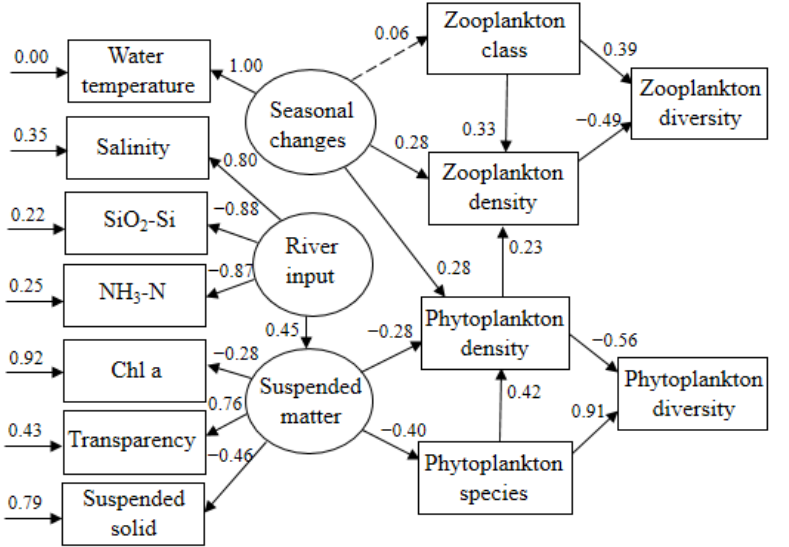
Figure 4. Final structural equation model after modification, with standardized coefficients. Solid arrows: significant influence; broken arrow: insignificant influence.